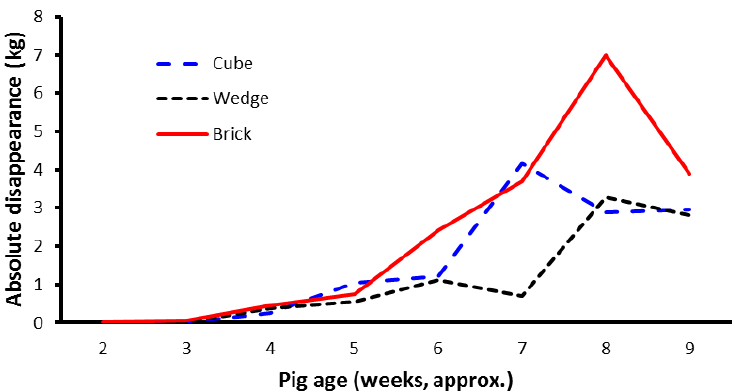
Figure 6. Absolute block disappearance of the shaped blocks over the course of the experiment. The data are predicted mean weights adjusted for number of pigs in the litter. Pigs were weaned at about age 28 days.